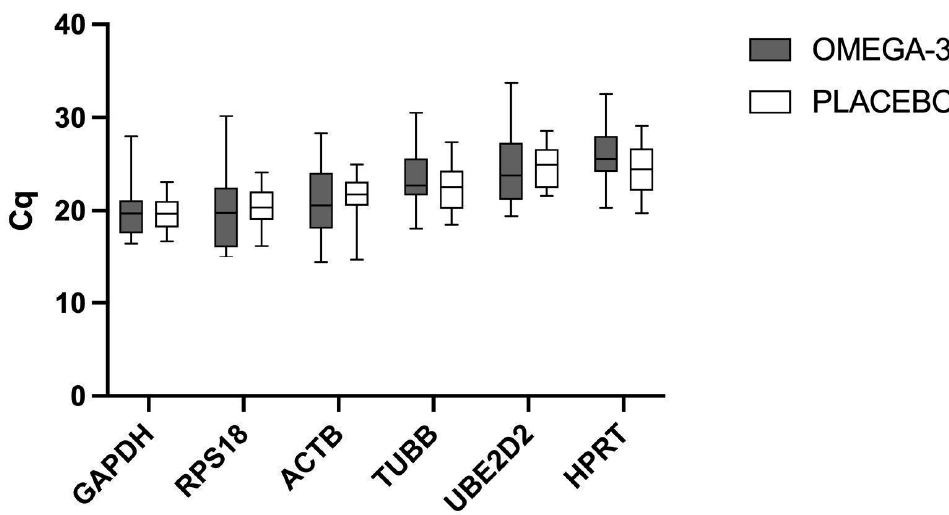
Figure 1. Comparison of Cq values for omega-3 supplemented vs. placebo group. The box plot for each reference gene represents the median, interquartile range, and the upper and lower range of raw Cq values for each experimental group. No statistically significant differences were found between groups.